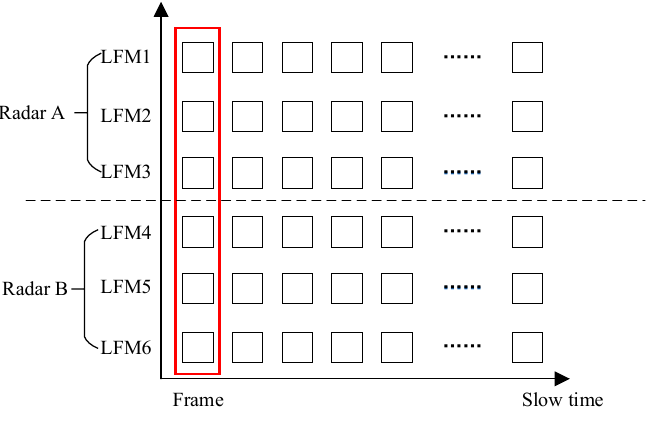
Figure 3. Characteristic matrices of two radars after matrix